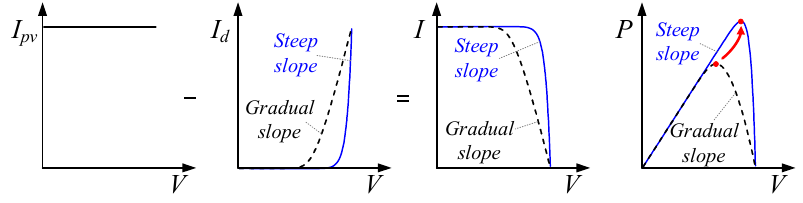
Figure 9. Effects of the slope on the I–V curve and P–V curve.